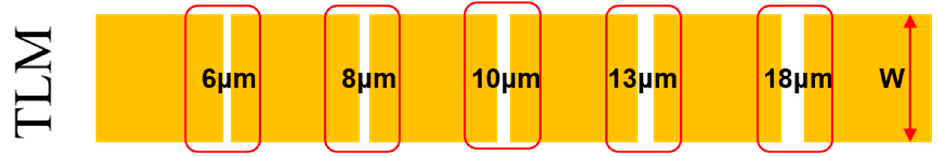
Figure 2. Top view of the transmission line method (TLM) structure.